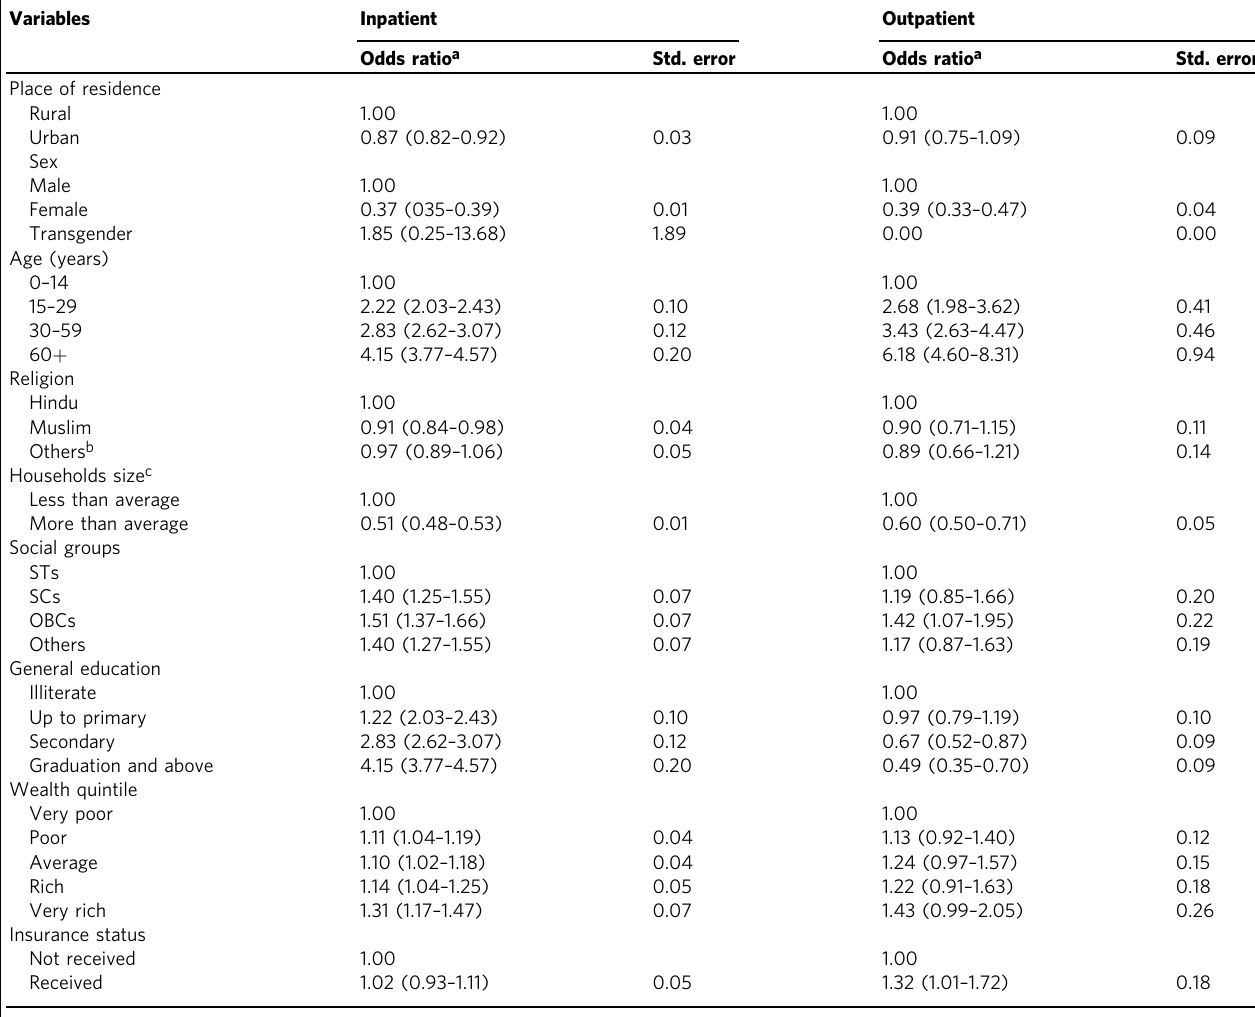
Table 6 Multivariate logistic regression of accidental injuries in India (2017 –